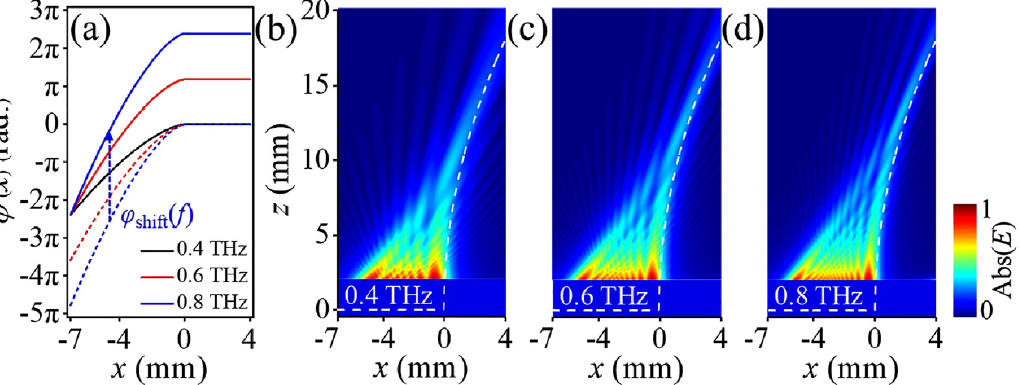
Figure 3: Fraunhofer diffraction integration of the phase profiles in Eq.(2) realized by PB phase. (a) Phase profile of an achromatic Airy beam with additional phase shift φ frequencies 0.4, 0.6 and 0.8 THz. The white dash lines are the parabolic trajectory curve f ( z